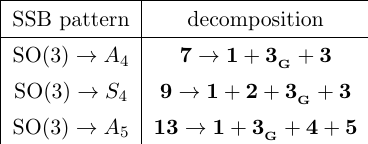
Table 14 . Scalar mass eigenstates for the SSB patterns SO(3) ! A 4 ; S 4 and A 5 using real symmetric tensor irreps of SO(3).